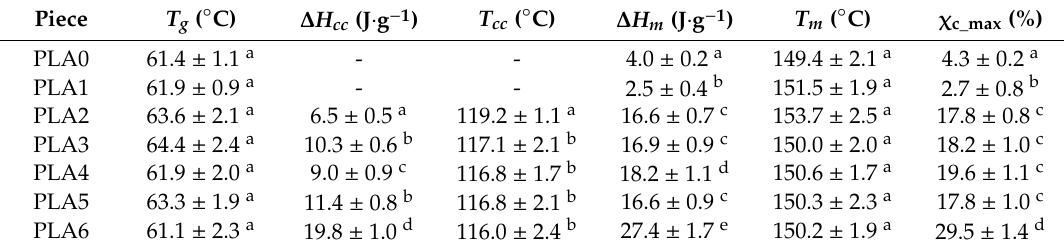
Table 3. Thermal properties of the injection-molded polylactide (PLA) pieces subjected to di ff erent reprocessing cycles in terms of glass transition temperature ( T g ), cold crystallization enthalpy ( ∆ H CC ), cold crystallization temperature ( T cc ), melting enthalpy ( ∆ H m ), melting temperature (T m ), and maximum degree of crystallinity ( χ c_max ). Piece T g ( ◦ C) ∆ H cc (J · g − 1